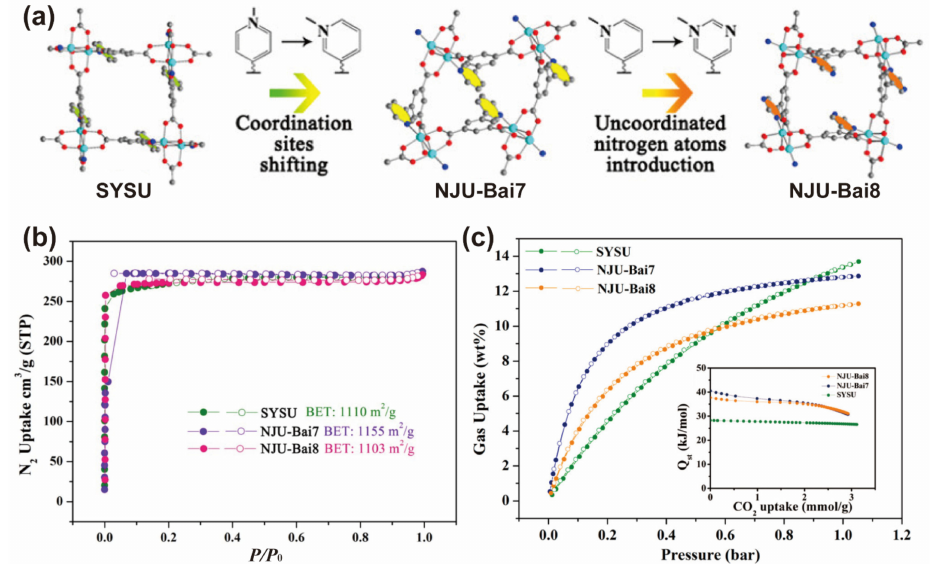
Figure 4. ( a ) Structure of SYSU ( left ), NJU-Bai7 ( middle ) and NJU-Bai8 ( right ). ( b ) N 2 sorption isotherms for SYSU, NJU-Bai7 and NJU-Bai8 at 77 K. ( c ) CO 2 sorption isotherms and CO 2 adsorption enthalpy (insert) for SYSU, NJU-Bai7 and NJU-Bai8 at 298 K. Reproduced with permission from Du et al., Journal of the American Chemical Society; published by American Chemical Society, 2013